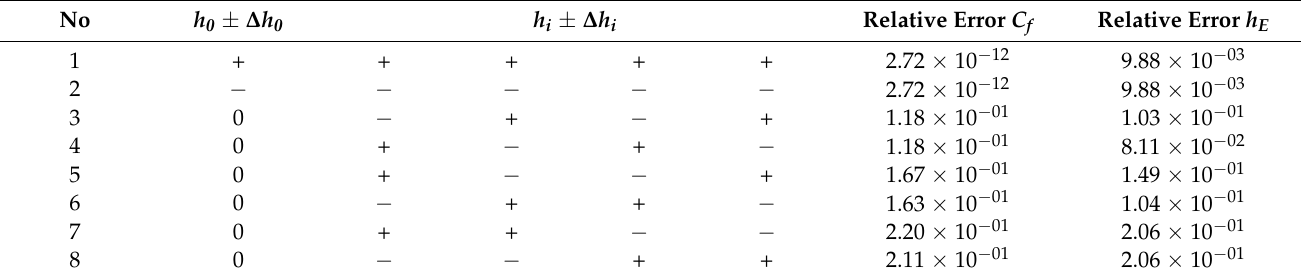
Table 4. Positive and negative error distributions of the sampling points ( N = 4).